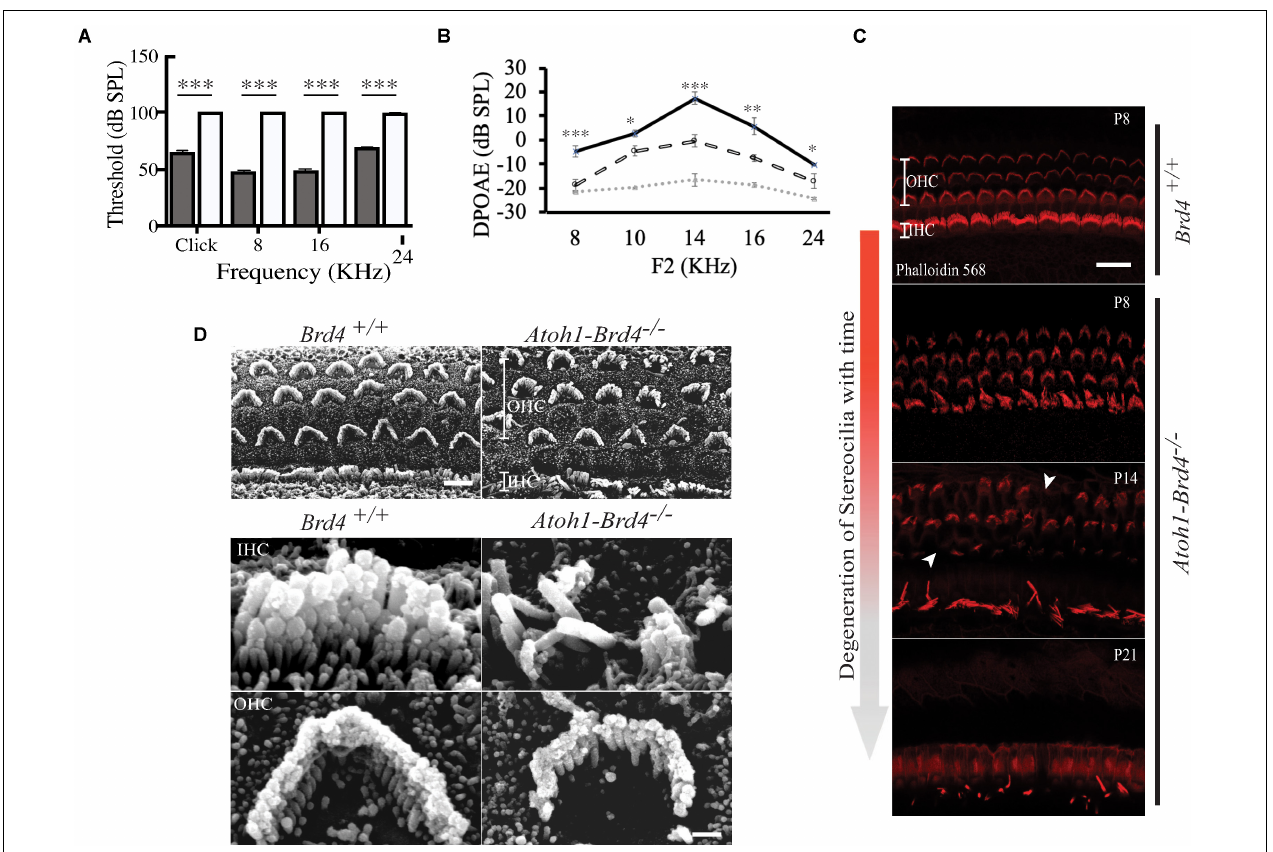
FIGURE 2 | Auditory Neuropathy and Stereocilia degeneration. (A) The ABR thresholds for click response in (gray) Brd4 + / + mice ( n = 4) were ∼ 65 dB SPL and ∼ 100 dB SPL in (white) Atoh1-Brd4 − / − ( n = 5). Similarly, for the pure-tone frequencies, Atoh1-Brd4 − / − mice had significantly elevated ABR thresholds ( ∼ 100 dB SPL) compared with control mice. (B) The DPOAE recordings of (dashed white line) Atoh1-Brd4 − / − ( n = 5) mice showed reduced amplitudes, from low to high frequencies (8–24 KHz) compared to (black line) Brd4 + / + group ( n = 5). Noise floor is indicated with a dotted gray line. (Standard T -test was performed to determine the significance of the experiment, ∗ p < 0.05, ∗∗ p < 0.01, ∗∗∗ p < 0.001, ns-not significant). (C) Z-stack of mouse cochleae (P8, n = 3; P14, n = 1; P21, n = 3) counterstained for actin filaments (red) (scale: 20 µ m) showed degeneration of stereocilia over time between P8 and P21 in Atoh1-Brd4 − / − . The white arrow heads represent the missing bundles of stereocilia. (D) SEM images of P8 ( n = 2) mouse cochleae processed using the O-T-O-T-O showed show the difference in the structural integrity of the stereocilia between Brd4 + / + and Atoh1-Brd4 − / − (Scale: 10 µ m upper panel; 2 µ M lower